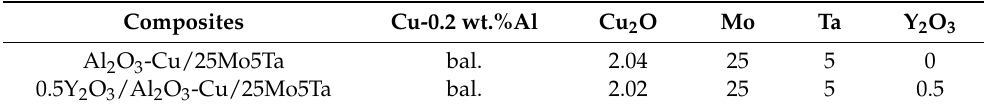
Figure 1. SEM of initial powders and composite powders: ( a ) Cu-0.2 wt.%Al powders; ( b ) Mo powders; ( c ) Ta powders; ( d ) Cu 2 O powders; ( e ) Y 2 O 3 powders; ( f ) Cu-0.2Al-Cu 2 O-25Mo - 5Ta mixed powders after ball milling; ( g ) Cu-0.2Al-Cu 2 O-25Mo - 5Ta mixed powders after ball milling in backscattering mode; ( h ) 0.5Y 2 O 3 -Cu-0.2Al-Cu 2 O-25Mo-5Ta mixed powders after ball milling; ( i ) Table 1. Theoretical compositions of the composites (wt.%).